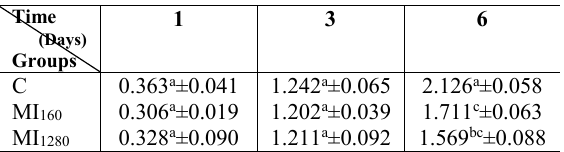
Table 2. Mean population doubling number of BMSCs after 1, 3 and 6 days of treatment with myo inositol.